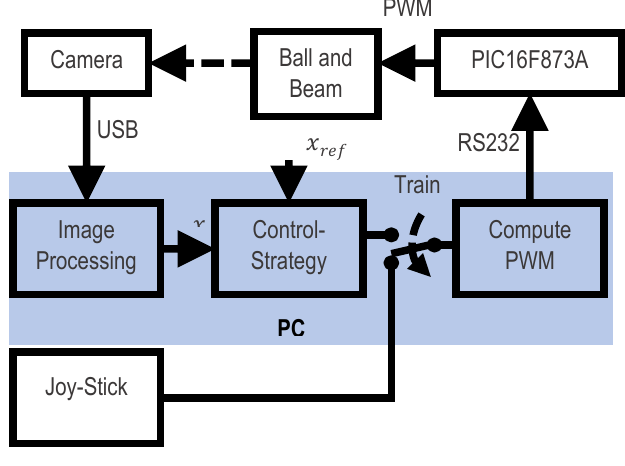
Fig. 3. Implementation of control strategies